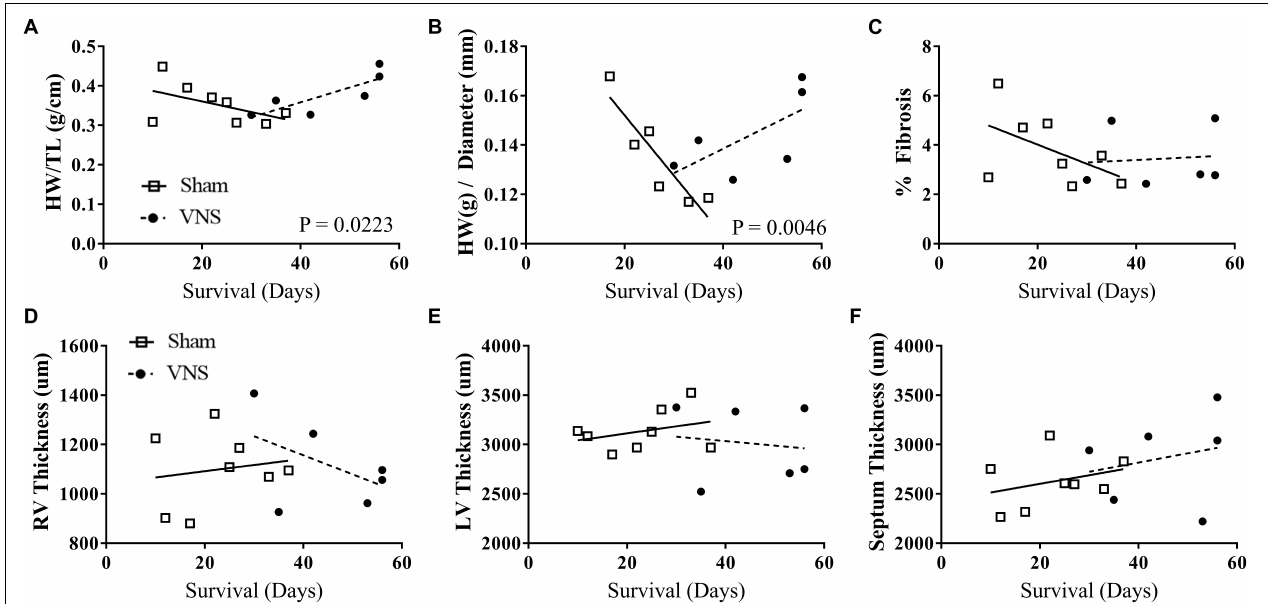
FIGURE 6 | Gross morphology and histology studies for Sham ( n = 8) and VNS ( n = 6) hypertensive rats. The effects of VNS on cardiac structural properties – (A) HW/TL, (B) HW/diameter, (C) percent fibrosis, (D) right ventricle (RV) and (E) left ventricle (LV) free wall thickness, and (F) septum thickness – as a function of survival rate along with corresponding linear regression